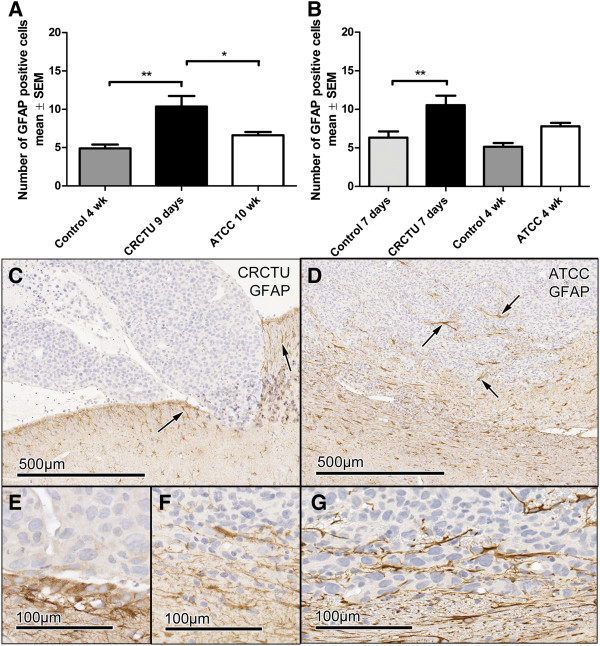
GFAP immunoreactivity. (A) Graph showing the average number of GFAP positive cells in 4 areas of the cortex (0.0678 mm2) in animals injected with culture medium, or injected with CRCTU or ATCC Walker 256 cells into the internal carotid artery; **p<0.01; *p<0.05. (B) Graph showing the average number of GFAP positive cells in 4 areas of the striatum (0.0678 mm2) following direct inoculation of culture medium, CRCTU or ATCC Walker 256 cells into the brain; **p<0.01. (C) GFAP immunostained section 9 days following CRCTU Walker 256 internal carotid artery injection, showing absence of staining within the tumour, but showing GFAP labelled cell in peritumoral area (arrows). (D) Brain section stained for GFAP 10 weeks following carotid ATCC Walker 256 tumour cell injection. Labelled astrocytes (arrows) are seen in the peritumoral area and in the periphery of the tumour mass between the tumour cells. (E) High magnification of GFAP immunostained section 9 days following CRCTU Walker 256 internal carotid artery injection. (F) High magnification of GFAP immunostained section 10 weeks following ATCC Walker 256 internal carotid artery injection. (G) GFAP immunostained section 7 days following direct inoculation of CRCTU Walker 256 inoculation showing substantial peritumoral immunoreactivity.